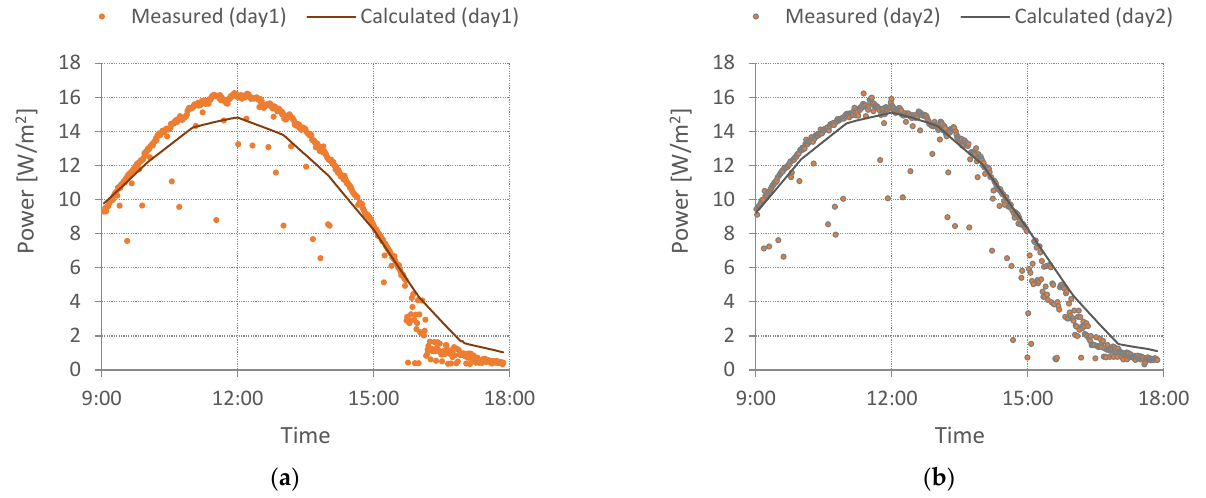
Figure 9. Power generation obtained by measurement and simulation: ( a ) first, ( b ) second day of analysis. Table 3. Energy produced by PV [Wh/m 2 ].